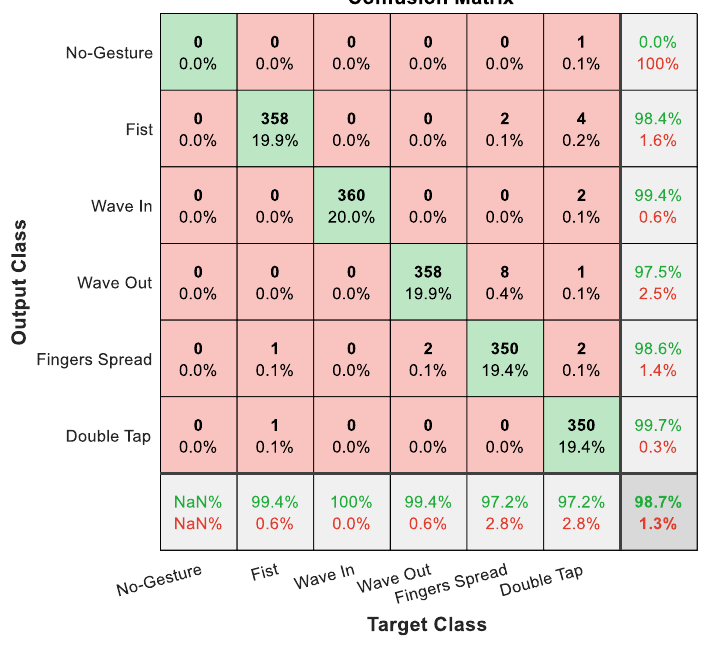
Figure 6. Confusion matrix of the results.